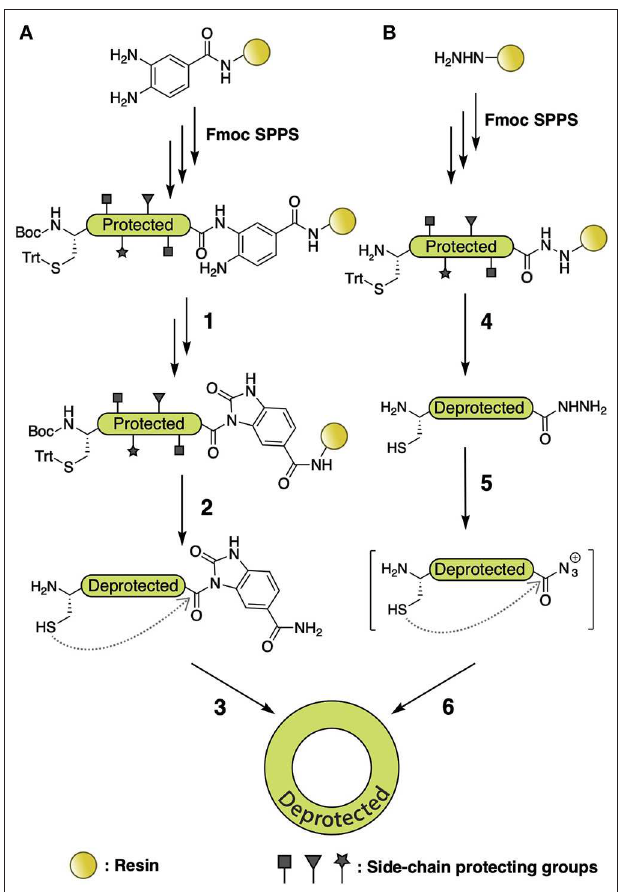
FIGURE 5 | (A) Fmoc N- acylurea strategy for backbone macrocyclic peptide synthesis. After peptide assembly, C-terminus is activated to an N- peptidyl-urea by addition of 4-nitrophenyl chloroformate (1), followed by cleavage and purification (2). The N- peptidyl-urea is subsequently cyclized by thiolysis and S-to-N acyl transfer (3). (B) Hydrazide methodology for backbone macrocyclic peptide synthesis. Fmoc SPPS is performed using hydrazine-Trt(2-Cl) resin, followed by cleavage and generation of a C-terminal peptide hydrazide (4), which is afterward activated with NaNO 2 to provide a C-terminal azide (5). That can be used for head-to-tail thiol exchange and S-to-N acyl transfer